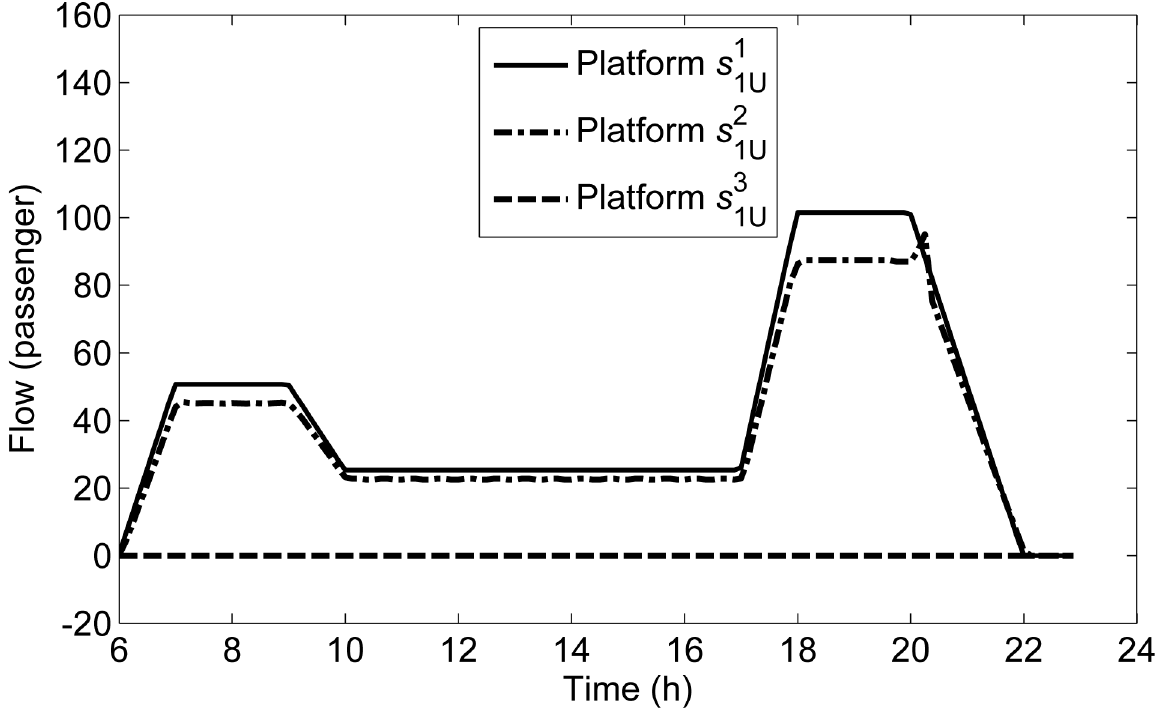
Fig 11. The transmitted flows of all platforms along L 1U